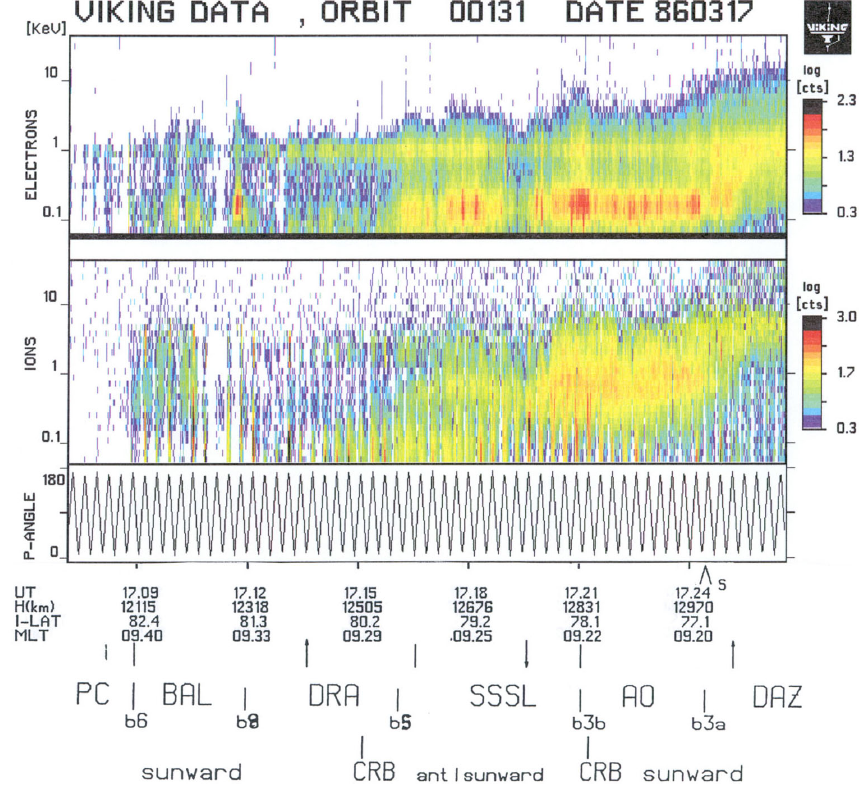
Fig. 5b. Viking particle spectrogram for orbit 131 on 17 March 1986, 1616–1727 UT. The plasma regimes and their boundaries, the convection reversal boundary (CRB) and field-aligned currents marked by arrows are given at the bottom: (b) the prenoon